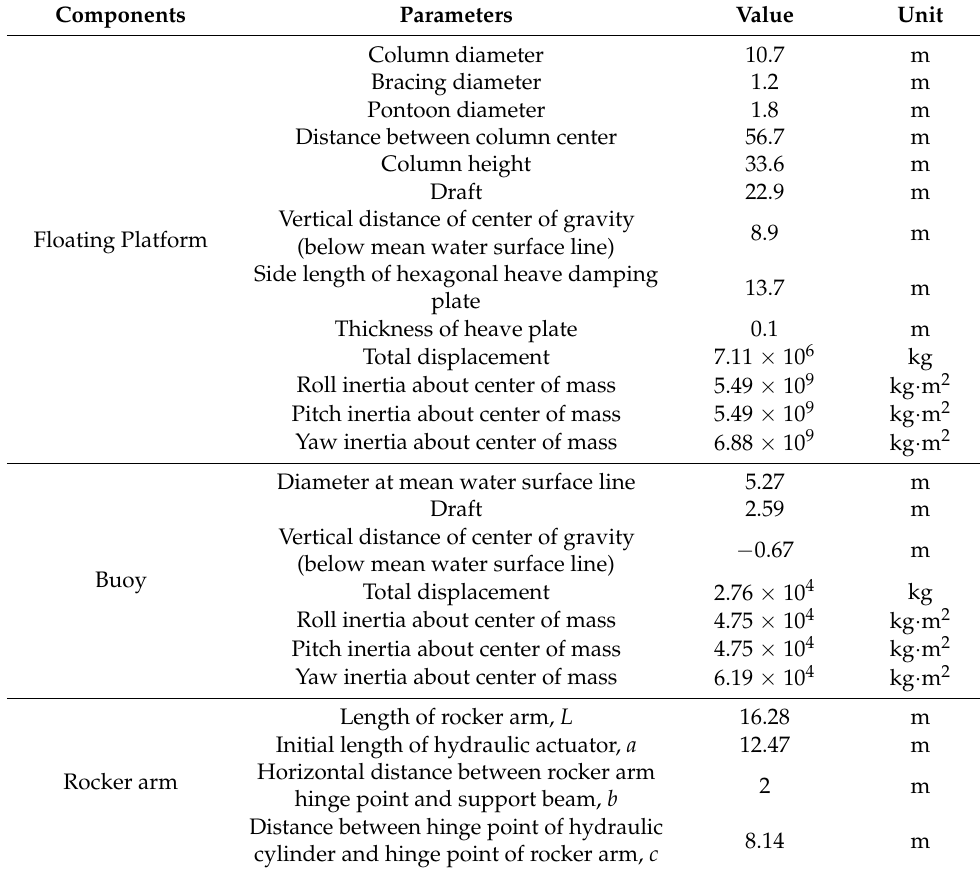
Table 2. Parameters of the floating platform and wave energy